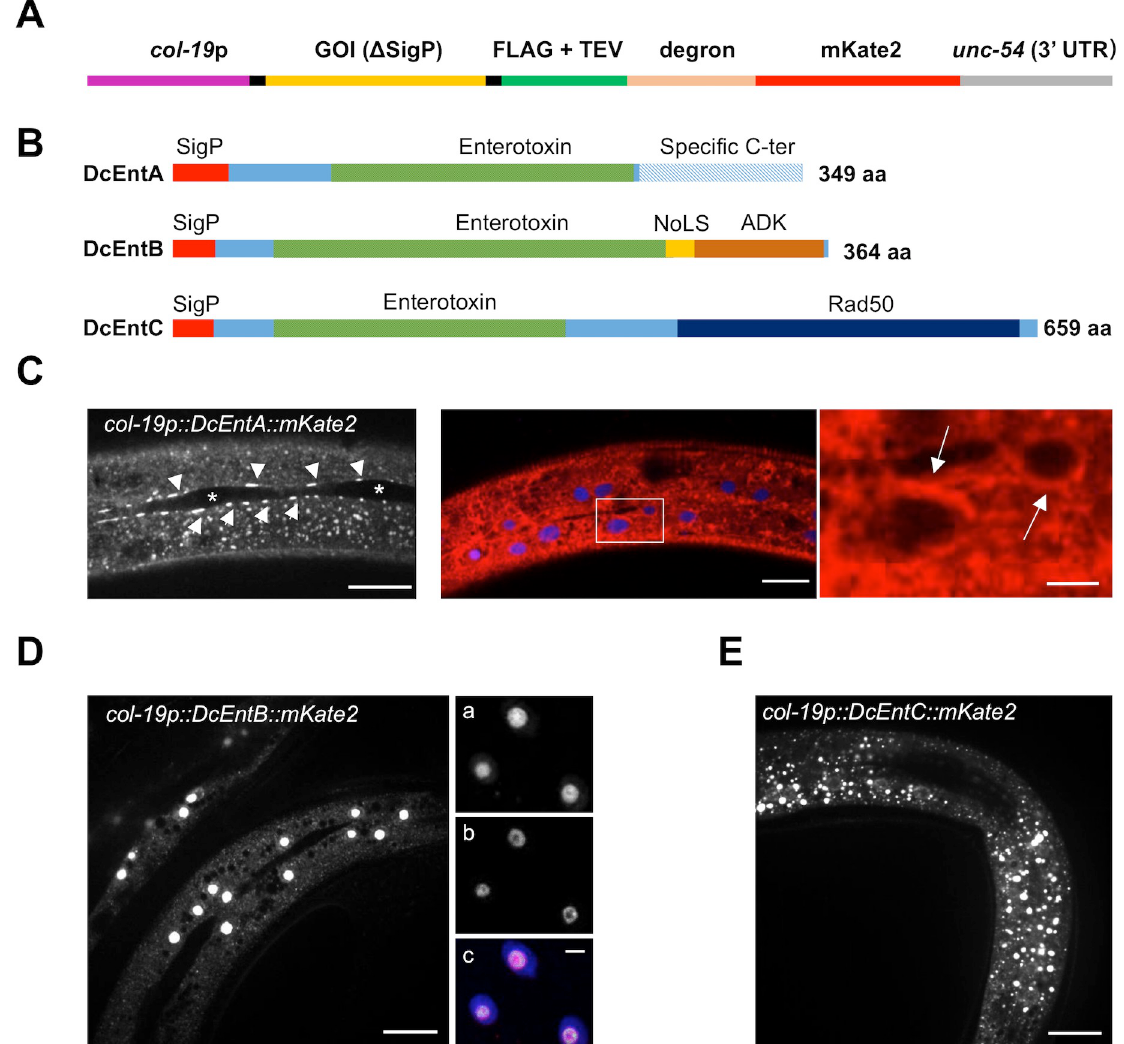
Fig 1. Three enterotoxins have different expression patterns in the epidermis. ( A ) Schematic overview of the plasmid insert used to express virulence factors. The candidate gene of interest (GOI), corresponding to a virulence factor without its signal peptide ( Δ SigP) and stop codon was cloned between the col-19 promoter and unc-54 3’ UTR, and expressed as a fusion protein with FLAG, tobacco etch virus (TEV) protease cleavage site, degron and mKate2. ( B ) Schematic overview of three selected enterotoxins from D . coniospora . The signal peptide (SigP) is represented in red, the heat-labile enterotoxin alpha chain domain (PFAM: PF01375) in green, a D . coniospora specific 90-residue C-terminal domain in DcEntA (hatched blue), the DcEntB nucleolar targeting sequence (NoLS) predicted by NoD [33] in yellow, the regions similar (p = 9.44e -3 ) to part of an adenylate kinase (ADK) domain (PRK13808), in brown, and DNA double-strand break repair ATPase Rad50 (PRK03918; 4.4e -5 ) in dark blue for DcEntC. The remainder of the proteins’ sequences is in light blue. Representative confocal fluorescence images of young adult worm expressing DcEntA::mKate2 (IG1926; C ), DcEntB::mKate2 (IG1925; D ), and DcEntC::mKate2 (IG1880; E ). ( C ) Left panel: DcEntA (arrowheads) adjacent to seam cells (asterisks). Middle: DcEntA (red) accumulation around nuclei (blue) is highlighted with arrows in the right panel showing a magnified view of the boxed area. Scale bars, left and middle, 20 μ m, right, 5 μ m. ( D ) Left panel: young adult IG1925 worm expressing DcEntB::mKate2. Scale bar, 20 μ m. Right: Image of young adult IG1984 worm expressing DcEntB::mKate2, FIB-1::GFP, and BFP-NLS (a: red channel; b: green channel; c: overlay red, green and blue channels). Scale bar, 5 μ m. ( E ) DcEntC::mKate2 appears as a punctate cytoplasmic pattern. Scale bar, 20 μ m.